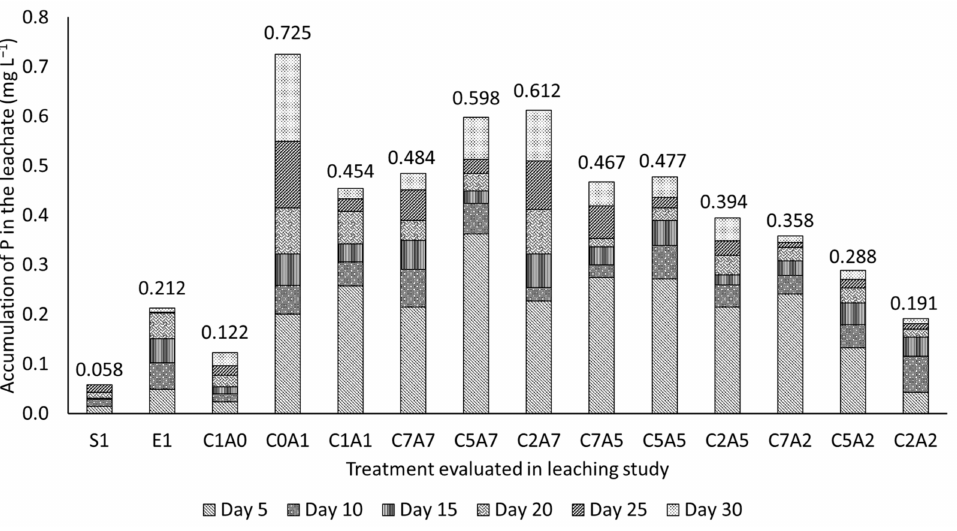
Figure 5. Treatments on cumulative concentration of phosphorus in leachate over thirty days of leaching, where S1: soil only; E1: soil with ERP only; C1: 100% charcoal; C0: 0% charcoal; C7: 75% charcoal; C5: 50% charcoal; C2: 25% charcoal; A1: 100% sago bark ash; A0: 0% sago bark ash; A7: 75% sago bark ash; A5: 50% sago bark ash; A2: 25% sago bark